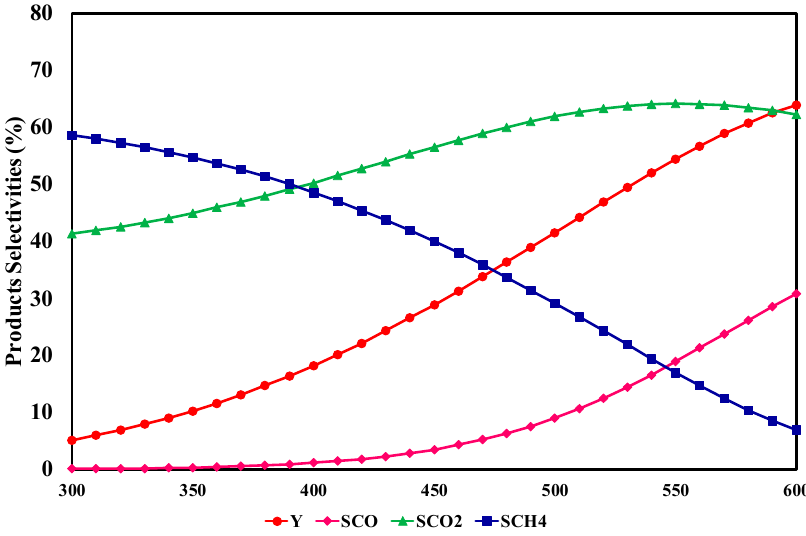
Figure 3. Hydrogen yield and CO, CO 2 and CH 4 selectivites as a function of reaction temperature predicted by thermodynamic equilibrium; H 2 O/EtOH = 4, O 2 /EtOH = 0.5.